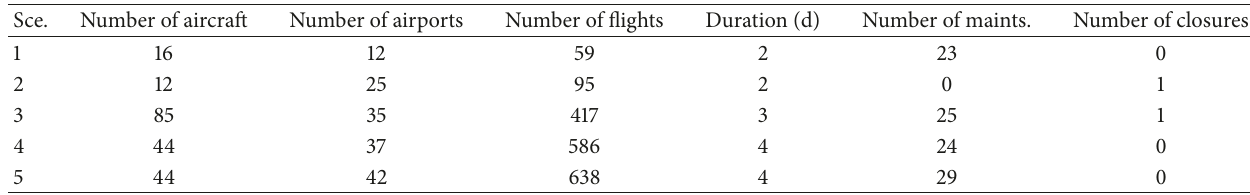
Table 1: Characteristics of the five test